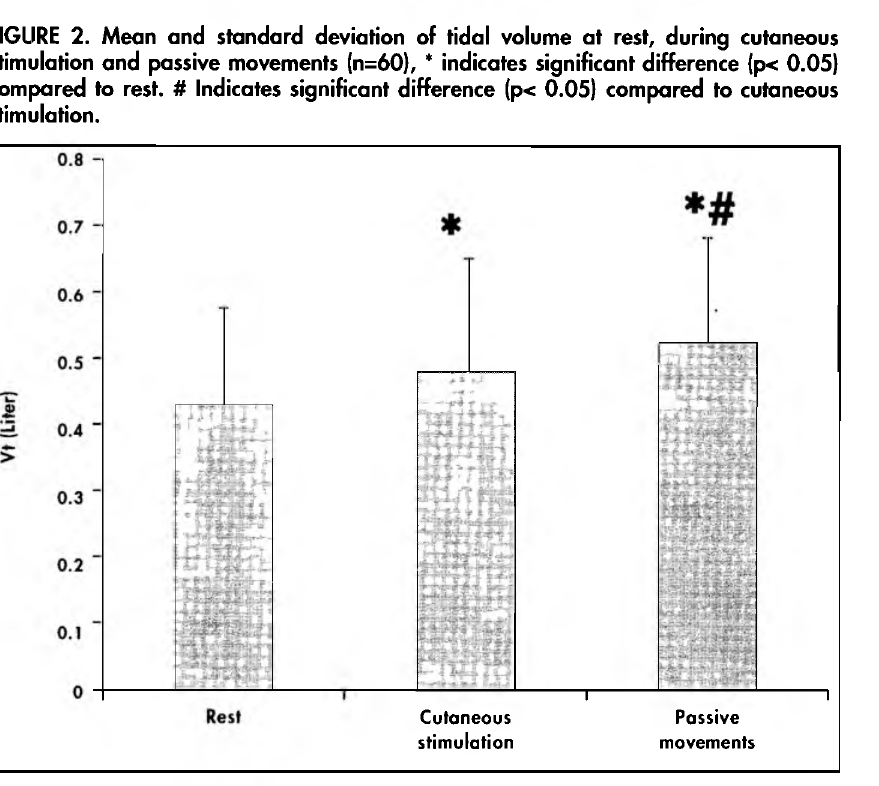
FIGURE 2. Mean and standard deviation of tidal volume at rest, during cutaneous stimulation and passive movements (n=60), * indicates significant difference (p< 0.05) compared to rest. # Indicates significant difference (p< 0.05) compared to cutaneous